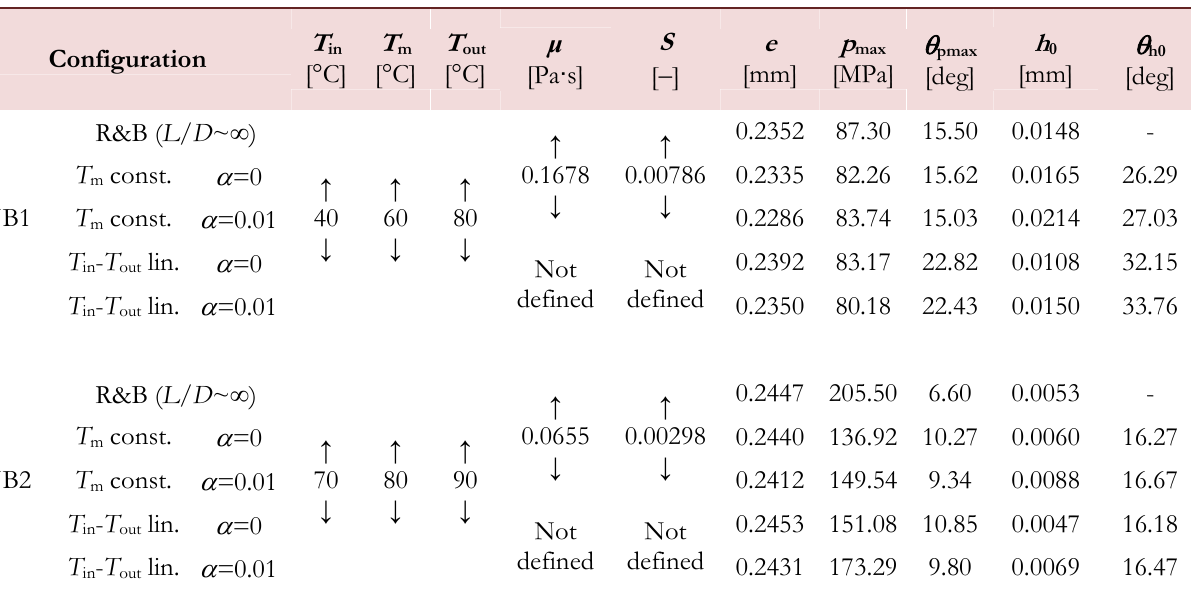
Table 2: Overall comparison of results for numerical simulations with rigid components.